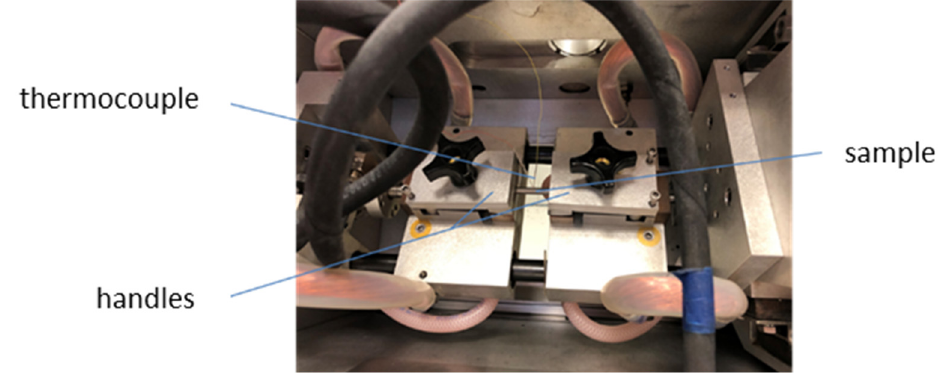
Figure 1. View of the measuring system for determining the NST (Nil Strength Temperature). The nil ductility temperature (NDT) and the ductility recovery temperature (DRT) were determined according to the diagrams presented in Figures 2 and 3, respectively. In